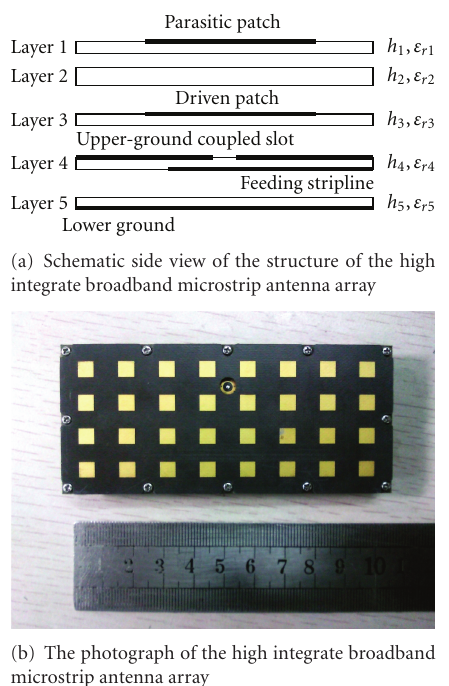
Figure 11: Ku-band high integrate broadband microstrip antenna array using MPCB technology.